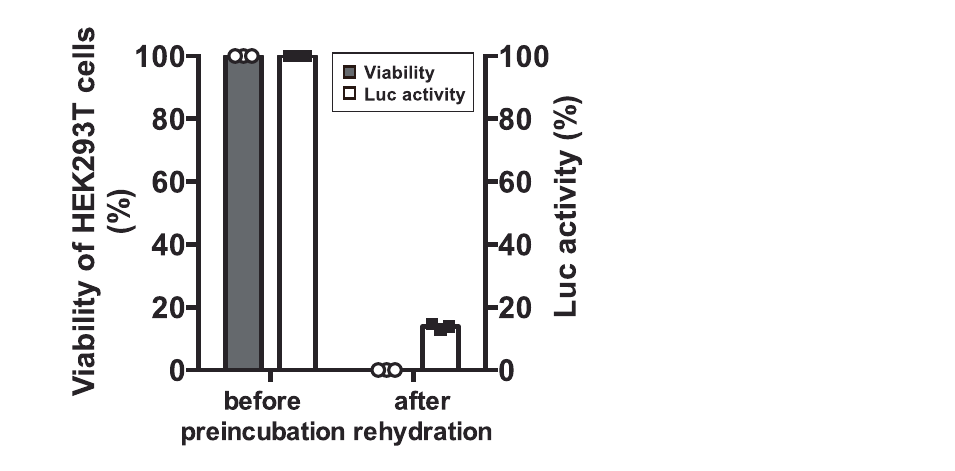
Figure 4. Cell viability and enzyme activity using a desiccation-sensitive mammalian cell line, HEK293T. HEK293T cells transiently expressing luciferase were preincubated with 600 mM trehalose and dehydrated following the same protocol used for Pv11 cells. Desiccated HEK293T cells were used for the measurement of cell viability and luciferase activity after rehydration. Viability of HEK293T-Luc cells (bars in grey) and the corresponding relative Luc activity (bars in white) are shown as a scatter dot plot (n =